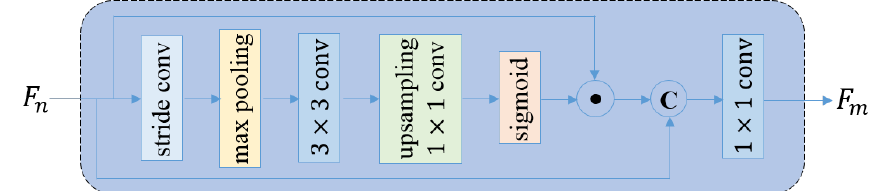
Figure 5. The structure of the regional focus block